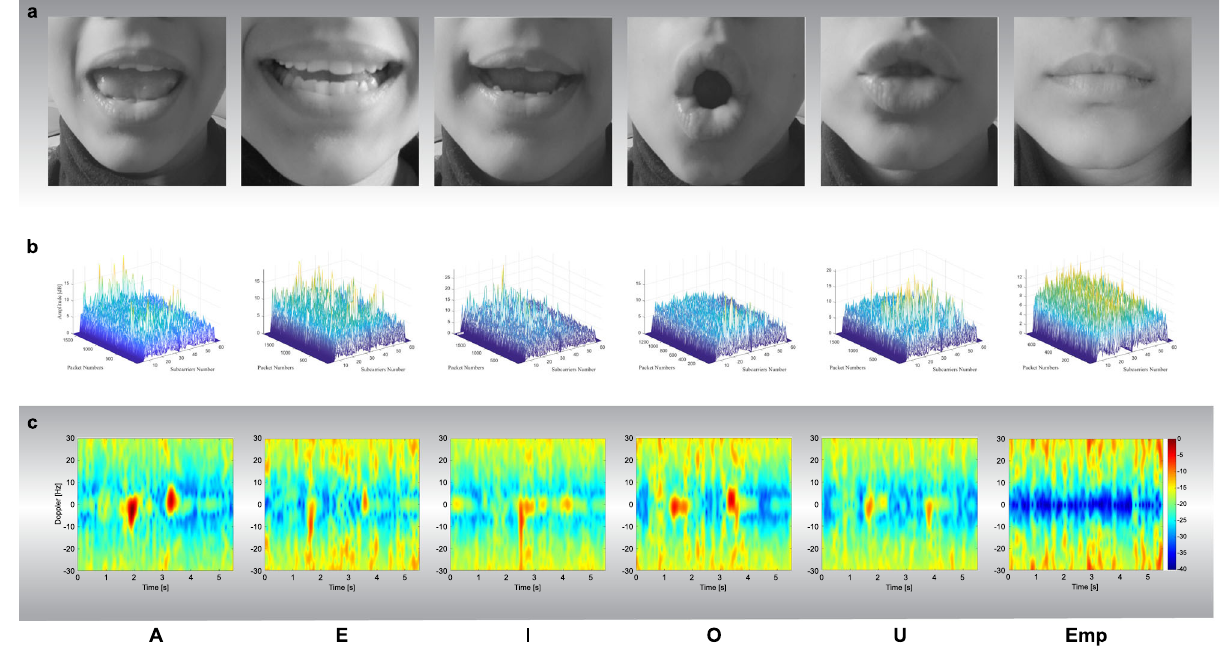
Fig. 2 | Pronounced vowels with their representationin Wi-Fiand radar signal. a A visual illustration of the pronounced vowels. b Wi-Fi data samples with mask